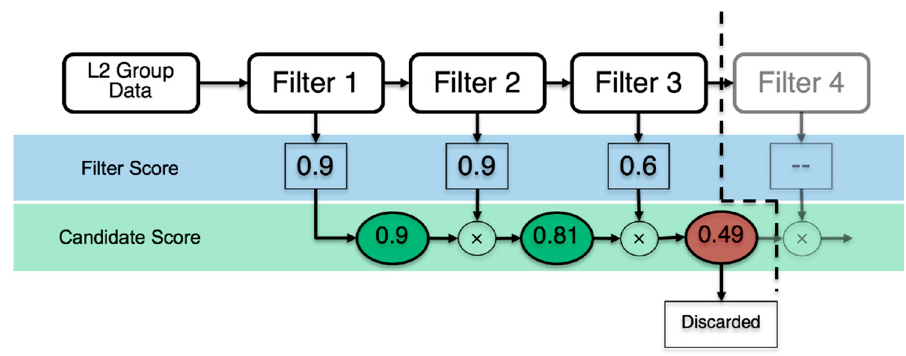
Figure 11. Algorithm architecture. The L2 group data passes through each filter sequentially and the product of the individual filter scores forms the cumulative candidate score. If the cumulative candidate score falls below the threshold value (here 0.5), the signature is discarded.